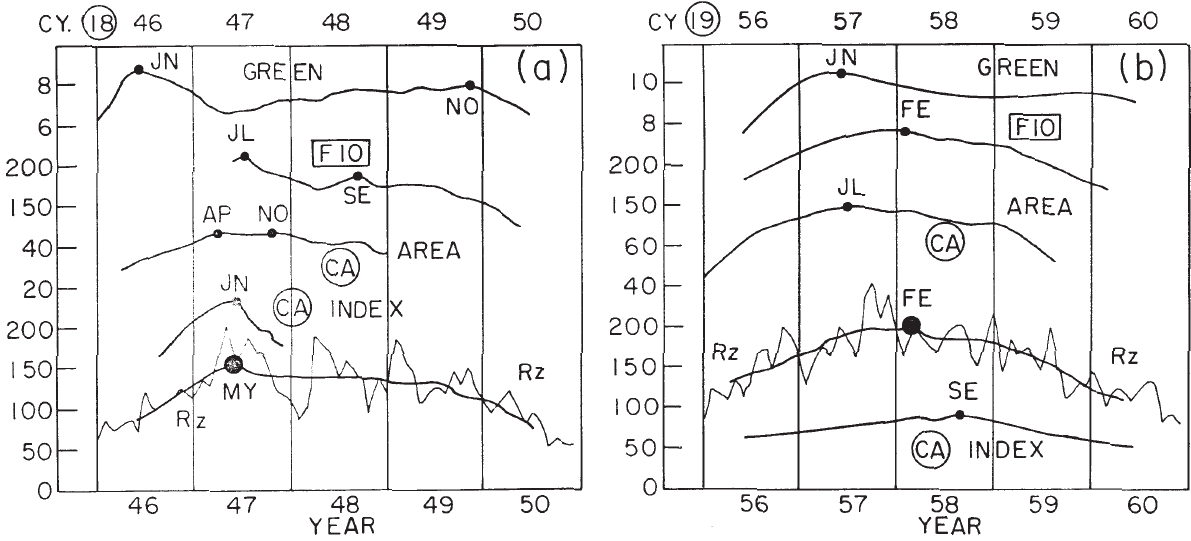
Fig. 2. Plots of various solar indices in years near sunspot maxima of (a) cycle 18, 1946–1950, and (b) cycle 19, 1956–1960. The full dots indicate